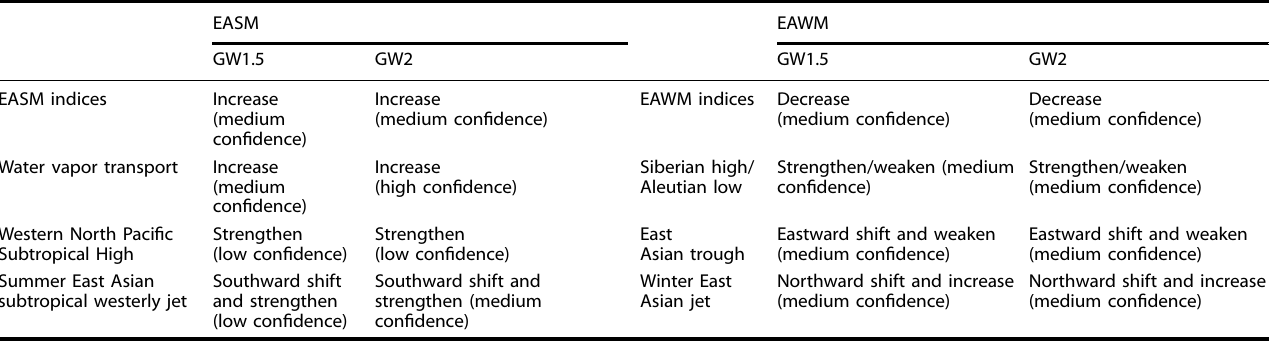
The con fi dences of the future changes are also